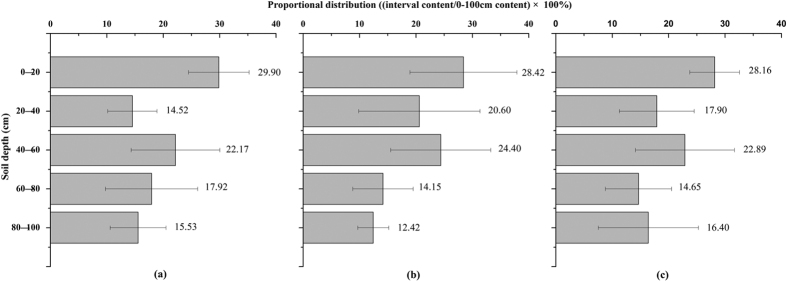
Profiles of volumetric SOC (SOCv) distributions in PSM (a), SSM (b) and TSSM (c). (mean + SD). There were not significant differences among the three salt marshes in the same layers (P > 0.05) based on one-way ANOVA.